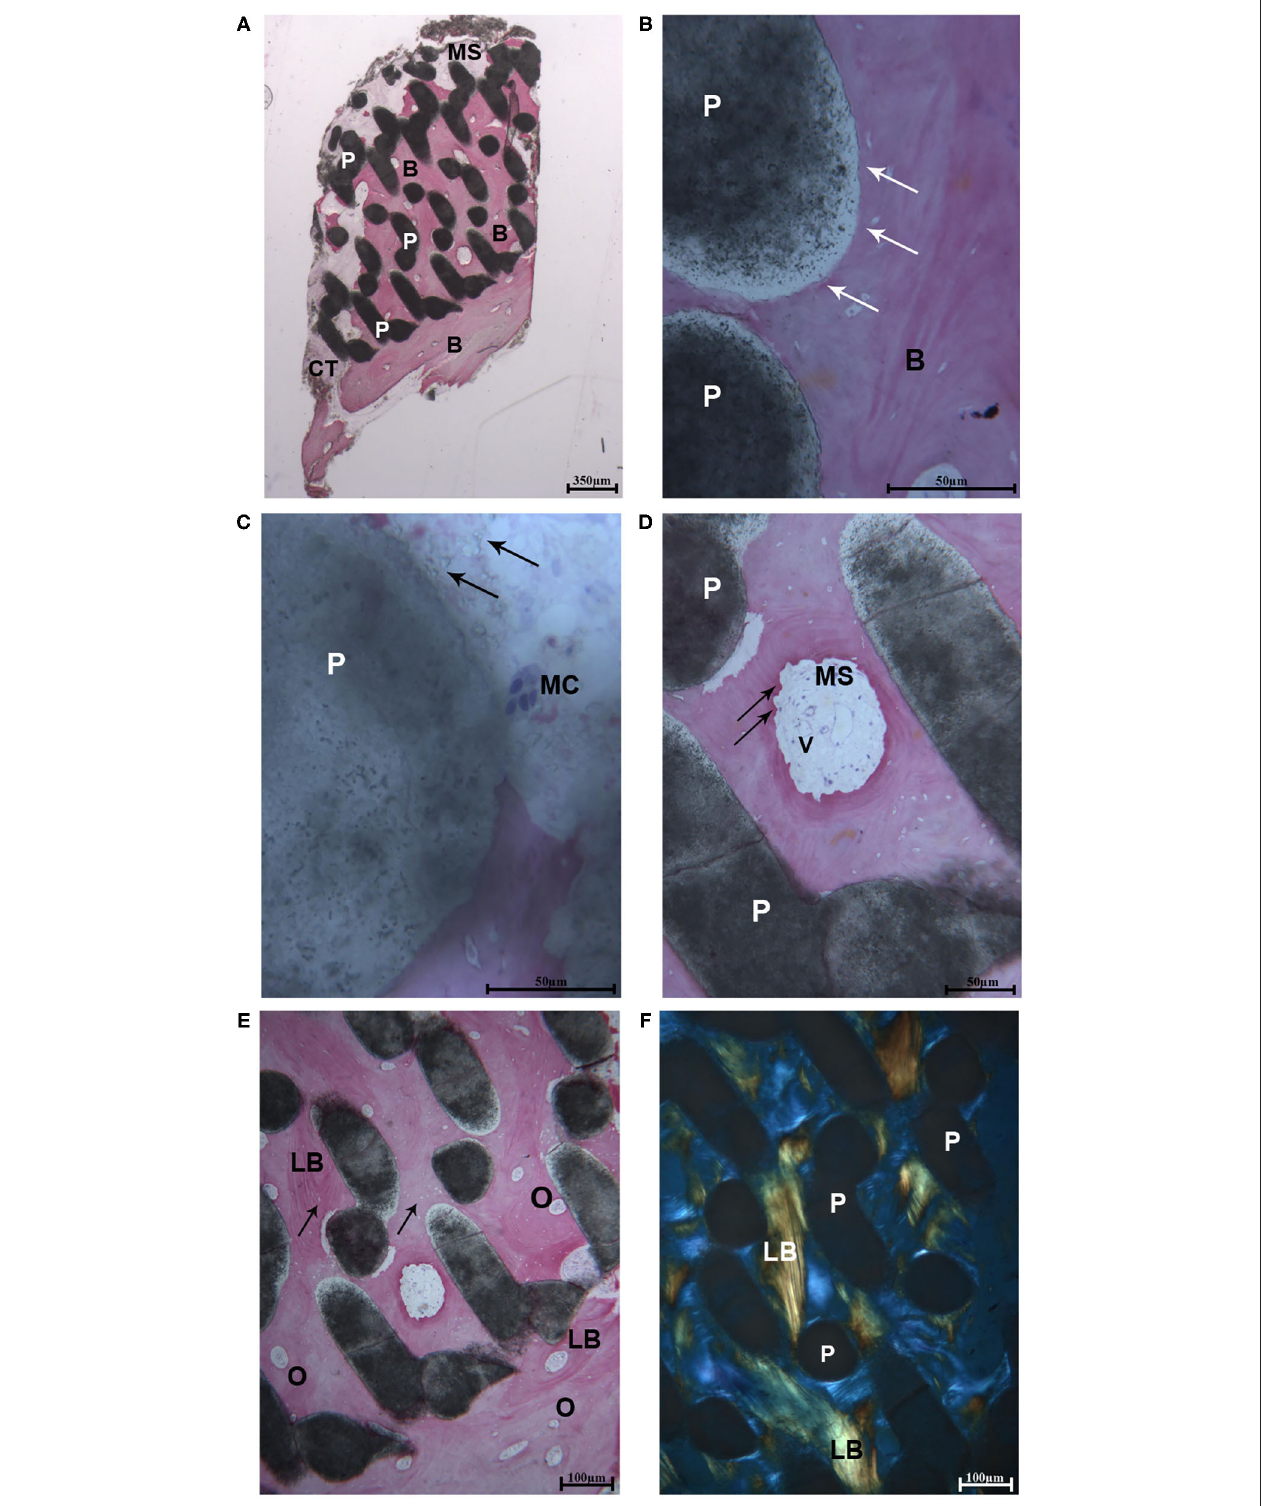
FIGURE 2 | (A) Light microscopic ground sections of the specimen showed the residual biomaterial block (P) surrounded by mature bone (B) . The bone marrow (MB) and a small portion of connective tissue (CT) were present. At the bottom of the samples (occlusal region), mature bone with very small marrow spaces was